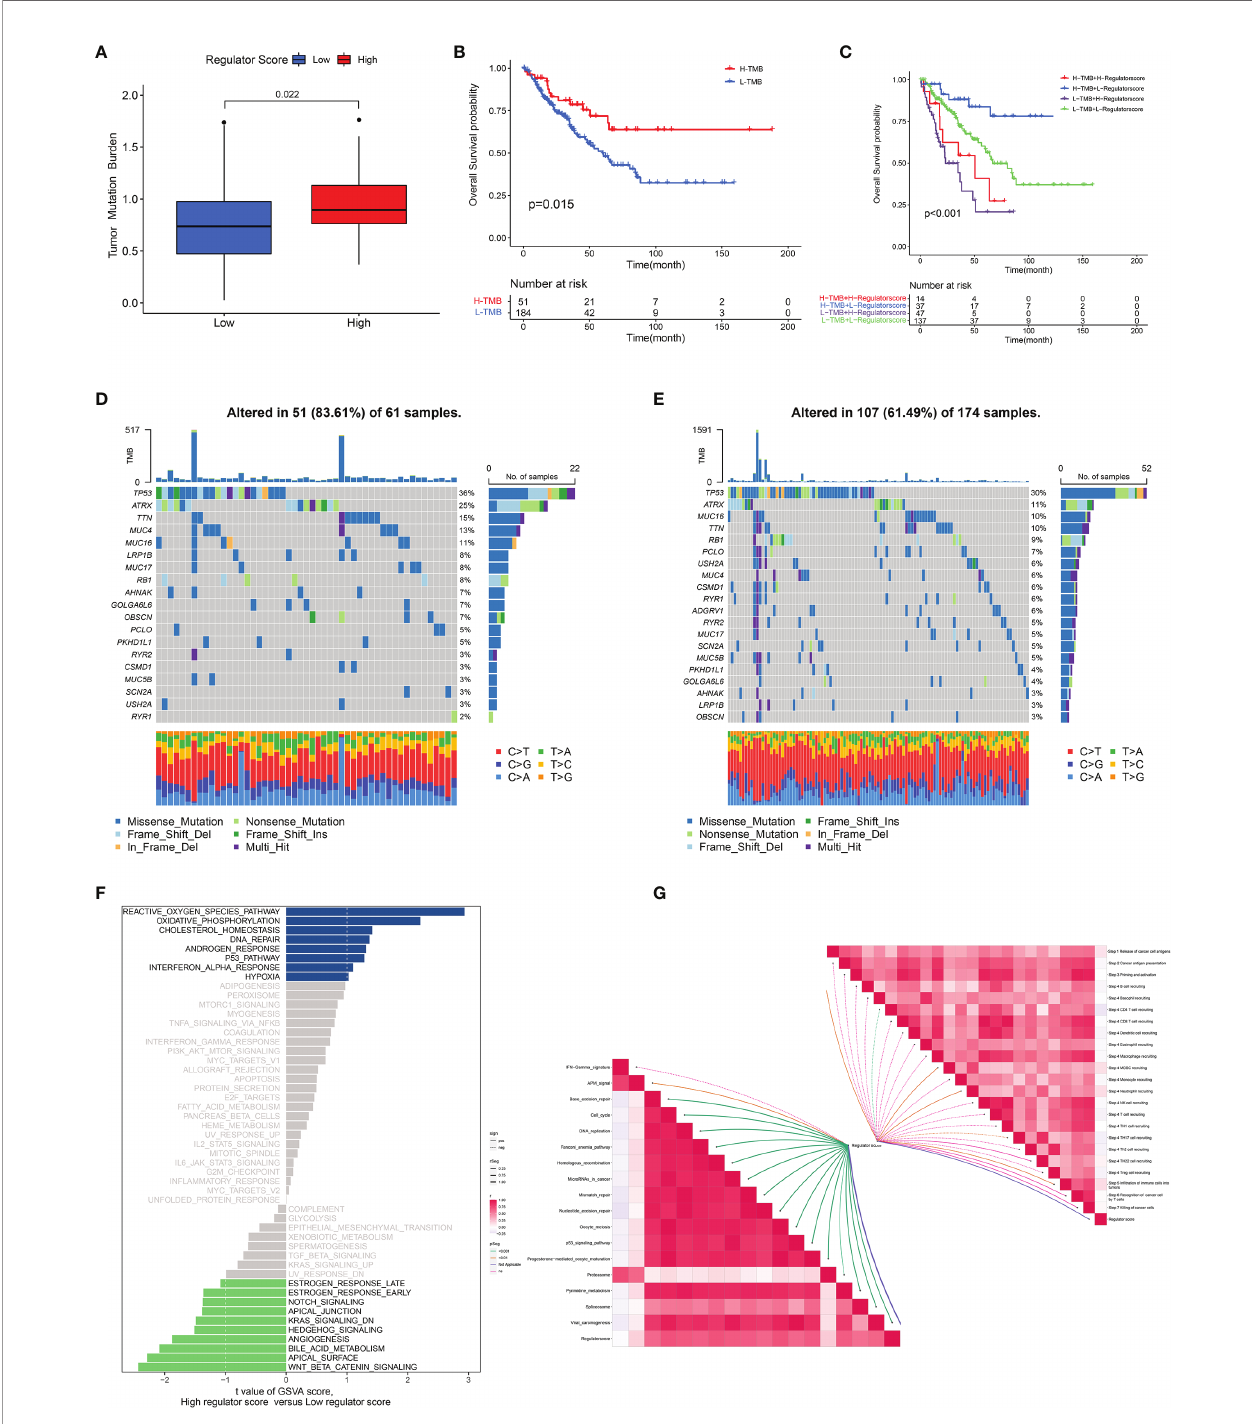
FIGURE 7 | Association between regulator score and biological processes. (A) The difference in the TMB level between low and high regulator score groups in the TCGA-SARC cohort. (B) The OS curve comparing survival of high- and low-TMB groups in the TCGA-SARC cohort. (C) The OS curve illustrating the subgroup analysis of TMB level and regulator score. (D, E) The somatic mutation frequency of high (D) and low (E) regulator score groups in the TCGA-SARC cohort. (F) Differences in pathway activities between low and high regulator score groups. (G) Correlation of the regulator score with immunotherapy-predicted pathways (lower left) and cancer immunity cycle (upper